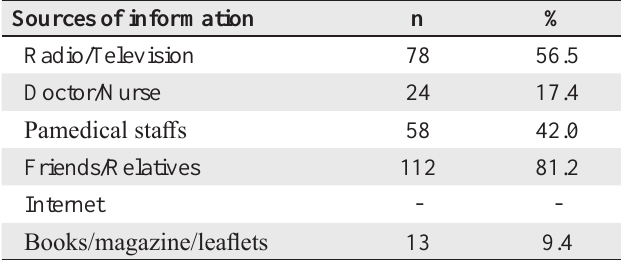
of knowledge regarding perimenopausal